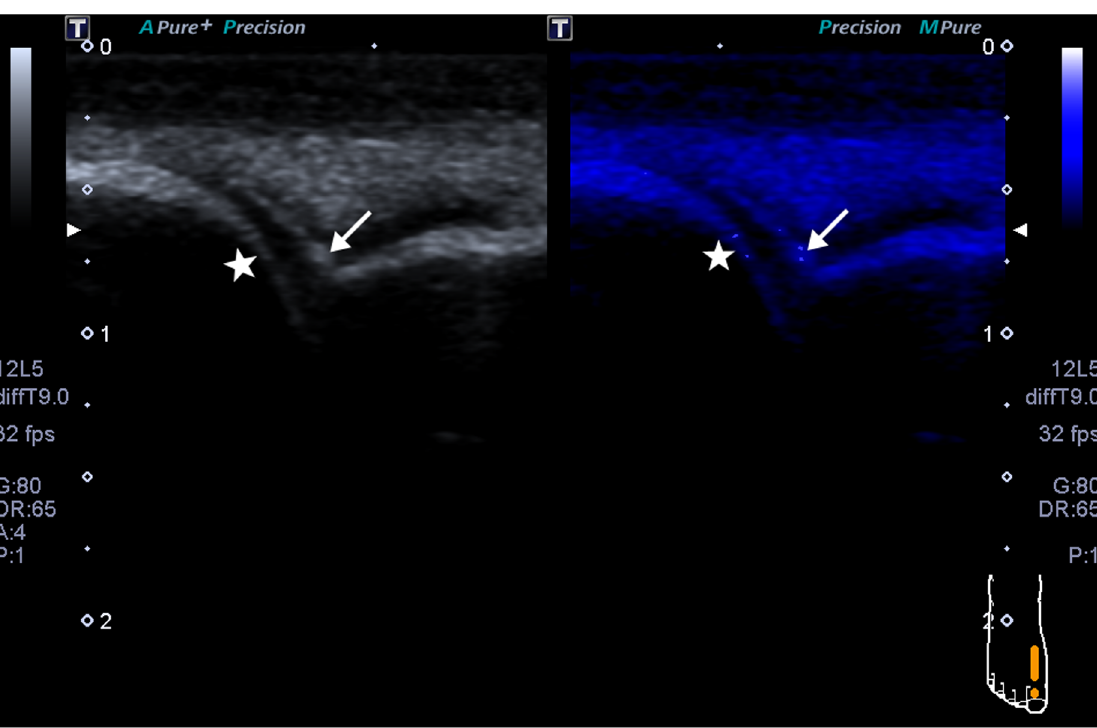
Figure 1. Longitudinal sonograms of the 1st MTP joint. Left: gray-scale US image; Right: MicroPure image. In the articular cavity, there are some microcalcifications (white arrows), which could be observed on both gray-scale US and MicroPure, but some microcalcifications are only observed on MicroPure (white stars).